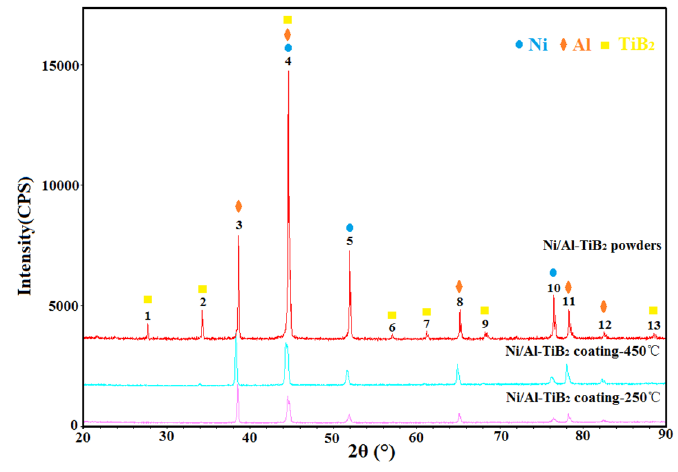
Figure 7. XRD patterns of Ni/Al-TiB 2 feedstock powder and as-sprayed coatings.